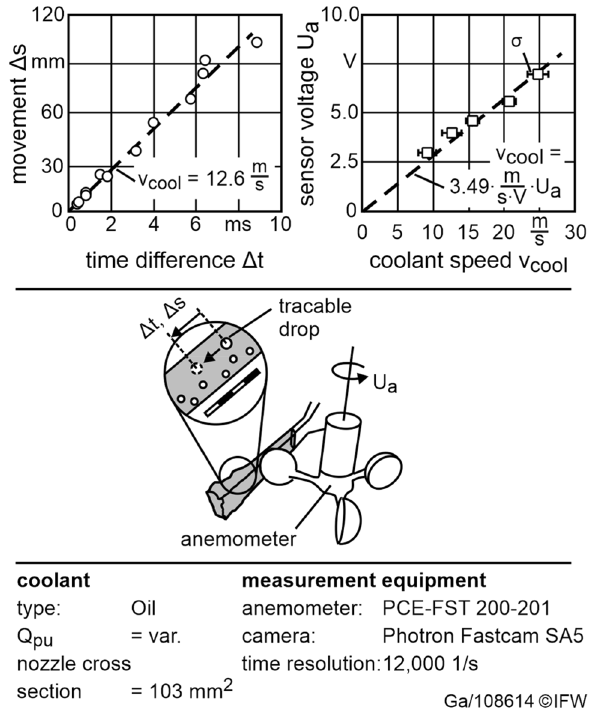
Fig. 10 Measurement results of the tracing of coolant drops by means of a high speed